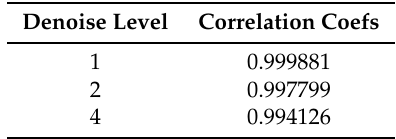
Figure 13. Wavelet Denoise with various levels using software implementation: ( a ) Noisy signal. ( b ) Wavelet denoise level 1—software version. ( c ) Wavelet denoise level 2—software version. ( d ) Wavelet denoise level 4—software version. Table 2. Software–hardware implementation similarity.